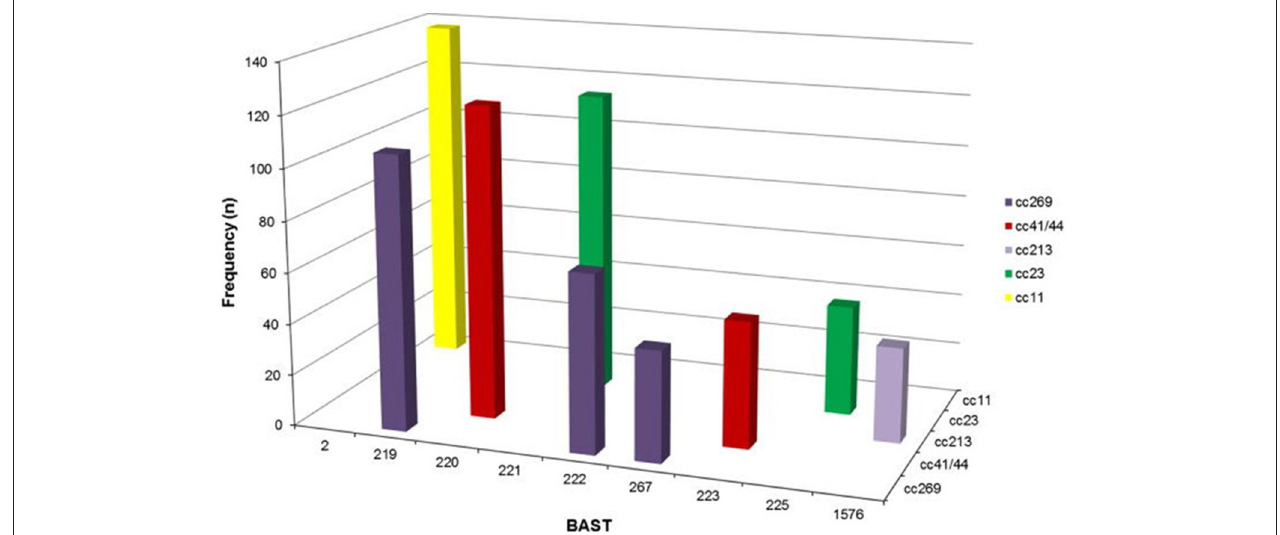
FIGURE 6 | Frequency distribution of Bexsero Antigen Sequence Typing (BAST) by clonal complex for the nine most frequently occurring BASTs ( n = 775/2,016, 39.4%) in invasive meningococcal disease isolates in the epidemiological years 2010/2011 to 2013/2014. BASTs shown on the x axis are structured by clonal complex (z axis) for a proportion of frequently occurring dominant clones circulating in Great Britain and Ireland from 2010/2014, for example BAST-2 is only found in isolates of clonal complex 11. Clonal complex 269 has three predominant BASTs, 219, 222, and 267 not found in other clonal complexes. Reproduced without modification from Brehony et al. (91) under CC